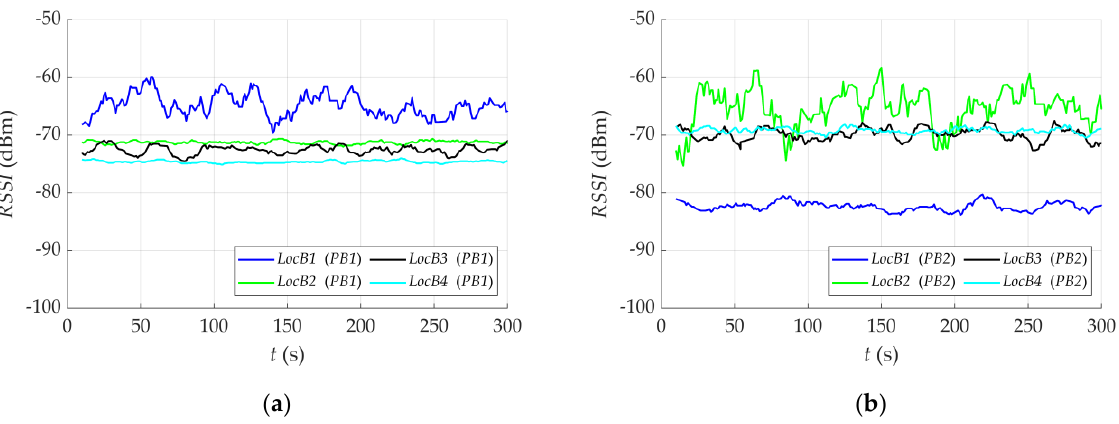
Figure 15. RSSI sequences averaged in a moving window with a width of M = 10 for four locator nodes and an object located at a distance of 1.8 m from the receiver: ( a ) LocB1 (location PB1 ); ( b ) LocB2 (location PB2 ).